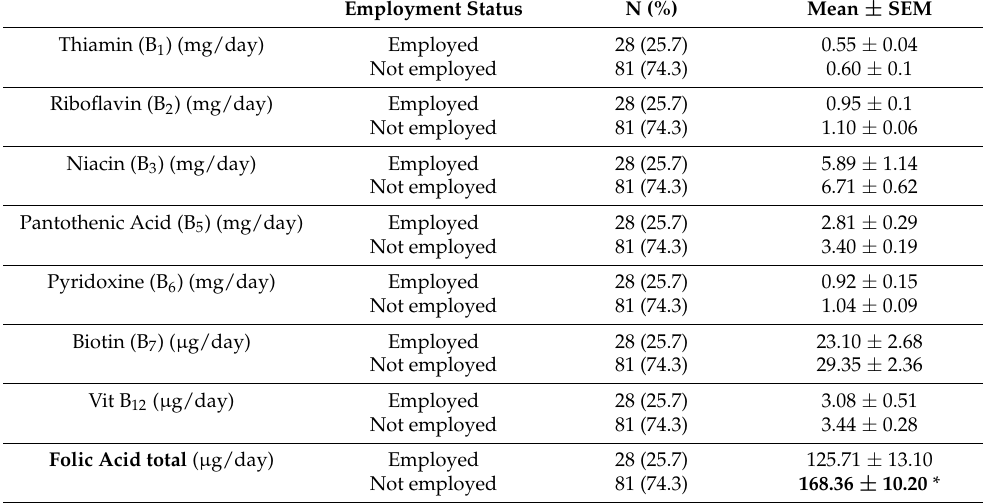
Table 4. Association of maternal employment status, education, income levels and dietary intake of B-complex vitamins for